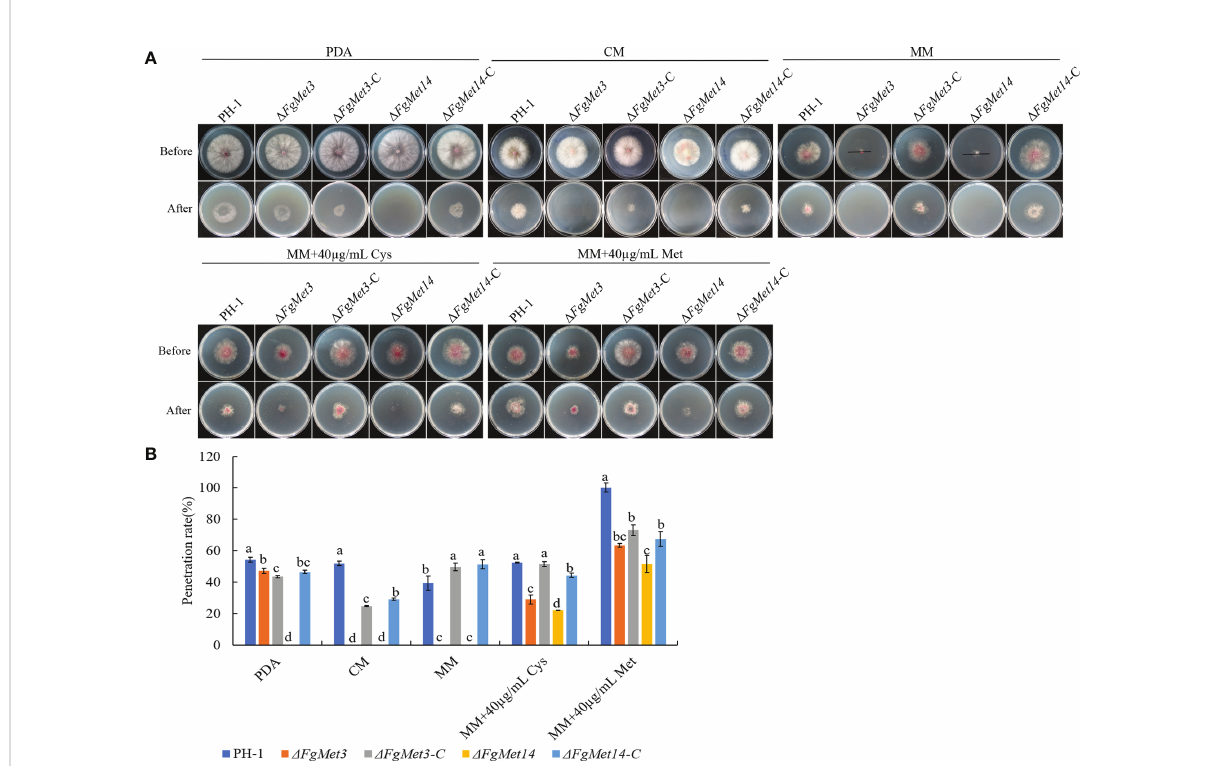
FIGURE 10 Defects of D FgMet3 and D FgMet14 mutants in plant penetration. (A) The penetration of strains. The sterilized double-layer cellophane was placed on PDA, CM, MM plates, and the MM plates containing 40 µg/mL methionine or cysteine for this experiment. (B) The penetration rate of strains. The penetration rate (%) = mean diameter after penetration/mean diameter before penetration × 100. Bars with the same letter indicate no signi fi cant difference according to the least signi fi cant difference (LSD) test at p =